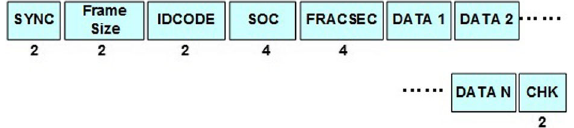
Fig. 12 The Various Fields of the Synchrophasor Message